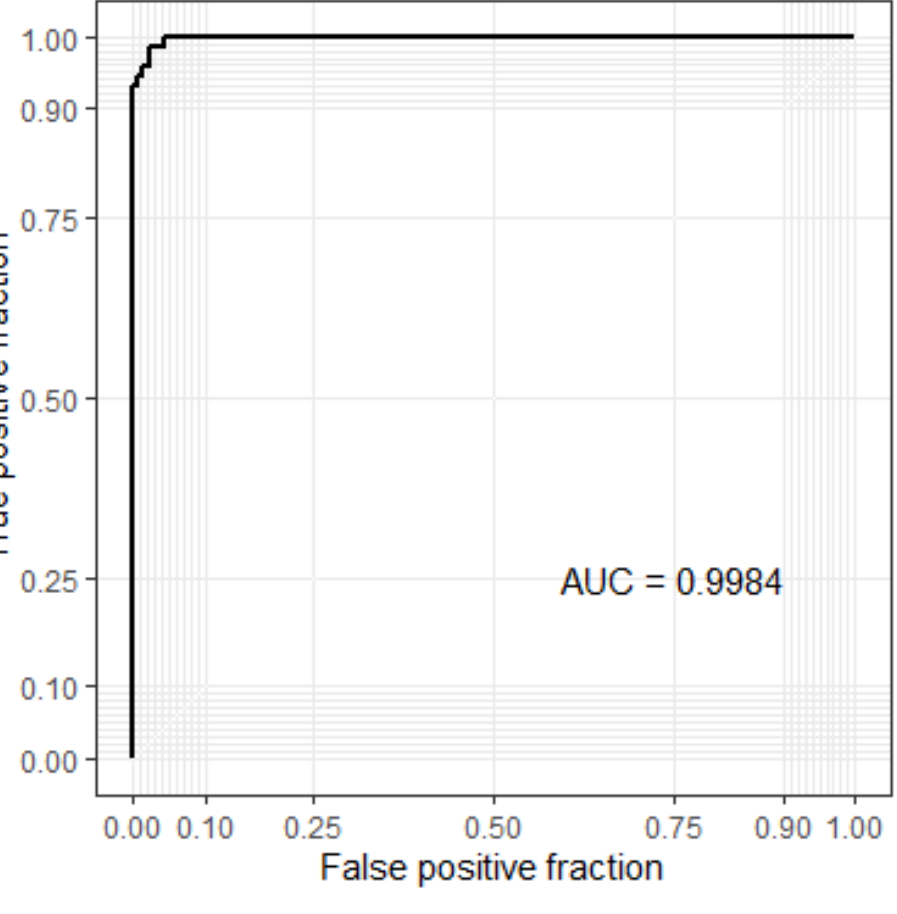
Figure 27. RF for the breast cancer